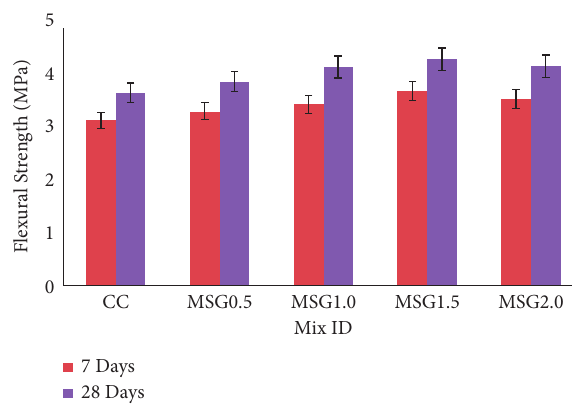
Figure 8: Flexural strength of various Table 3: Durability properties of various mixes.